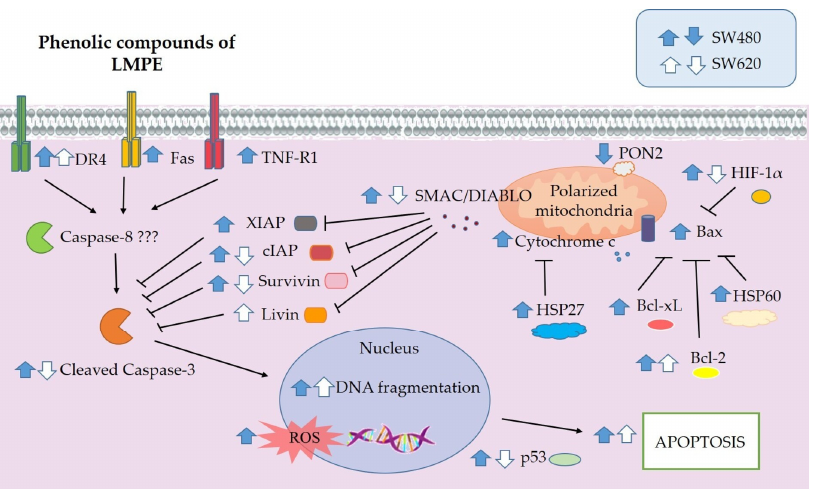
Figure 7. Overview of signaling pathways possibly modulated by LMPE in SW480 and SW620 cells. The blue (SW480) and white (SW620) arrows indicate the possible upward or downward regulation of the selected proteins or the studied biological processes.